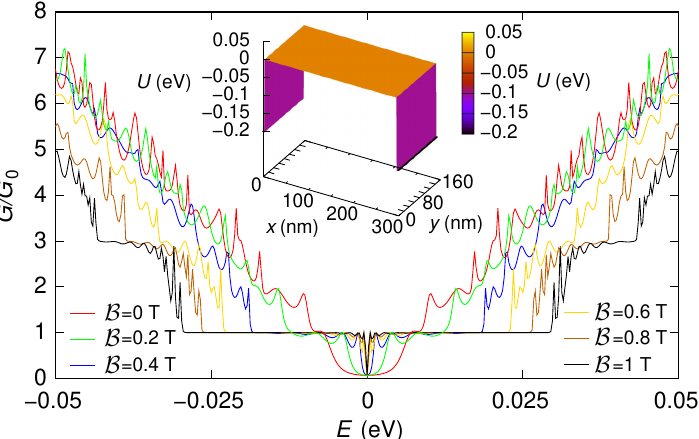
Figure 3. Conductance G , normalized with respect to the conductance quantum G 0 , which was obtained as a function of the Fermi energy E for six values of the orthogonal magnetic field B for the 150 nm-wide and 300 nm-long graphene ribbon with zero potential and two 5 nm-long sections at the entrance and exit, which represent abrupt contacts (with a modulus of 0.2 eV for the potential steps of the contacts). In the inset, we represent the potential profile that we have